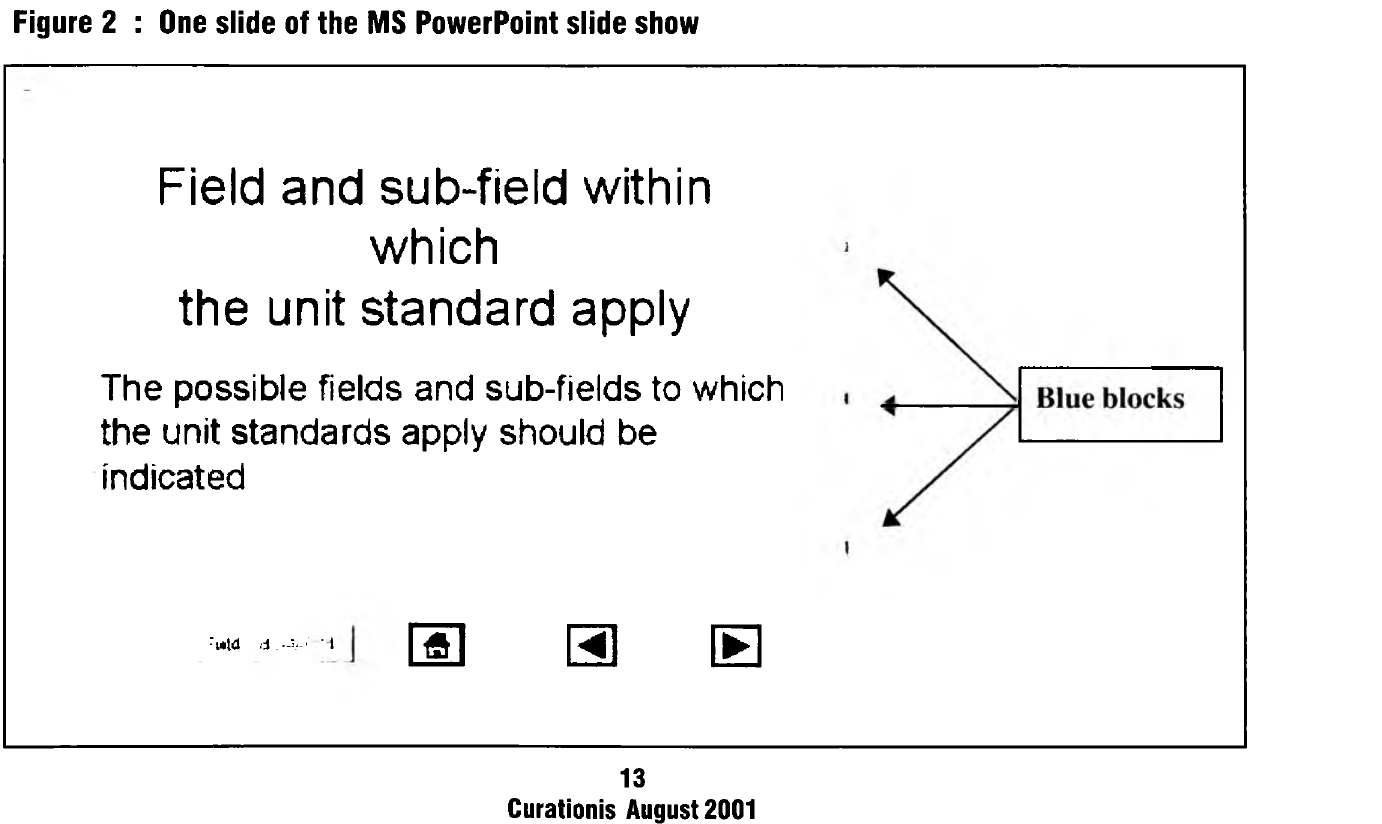
Figure 2 : One slide of the MS PowerPoint slide